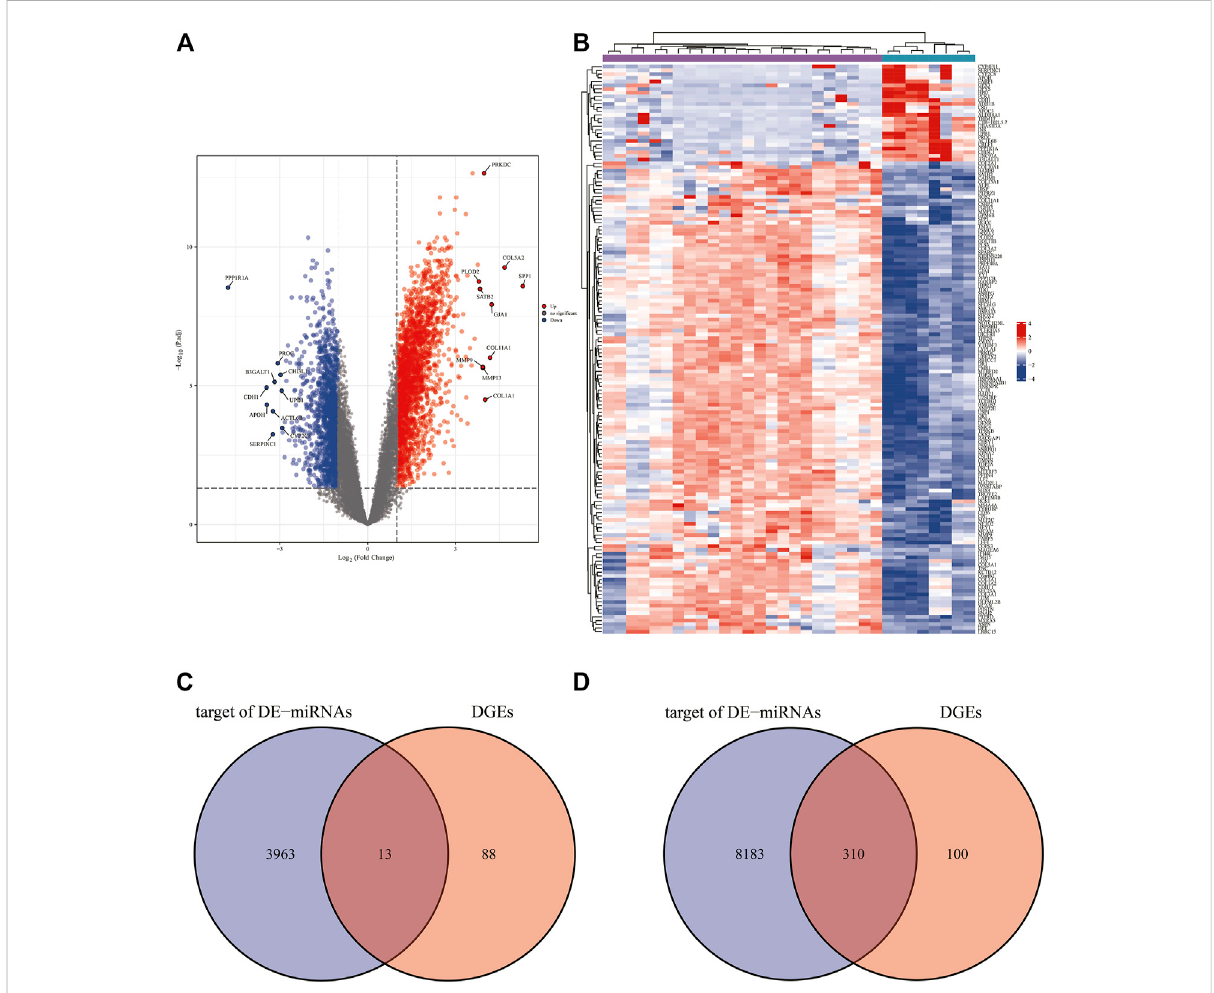
FIGURE 4 Predication oftarget genes. (A) Thevolcano plotsand Heatmapsshowing alltheexpressedgenes fromGSE14359 andGSE16088. (B) The Heat maps showing all the expressed genes from GSE14359 and GSE16088. (C) The Venn diagram of mRNAs from the overlap between 101 down- regulated DEGs and 3975 target genes predicted from two up-regulated DE-miRNAs. (D) The Venn diagram of mRNAs from the overlap between 410 down-regulated DEGs and 8493 target genes predicted from two up-regulated